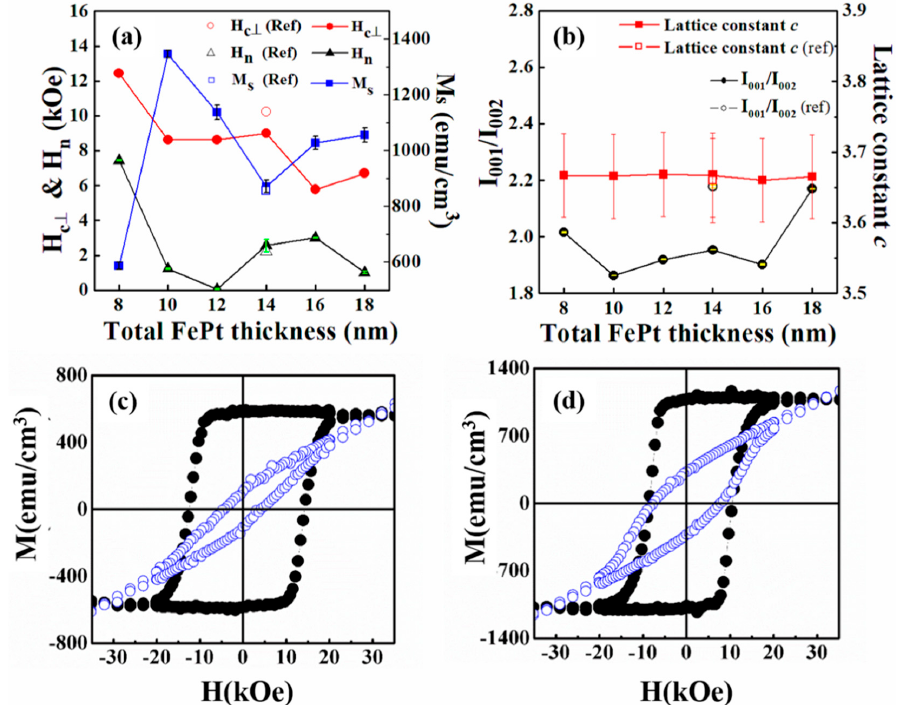
Figure 2. The variation of ( a ) saturation magnetization (M s ), out-of-plane coercivity (H c ) and nucleation field (H n ); ( b ) I(001)/I(002) and lattice constant c with total FePt thickness for series (I) samples. Out-of-plane (- • -) and in-plane (- o -) field-dependent magnetization loops of FePt(t nm)/[MgTiTaON(1 nm)/FePt(4 nm)] 2 /MgTiON/CrRu, ( c ) t = 0 and ( d ) t = 10 films measured at room temperature.